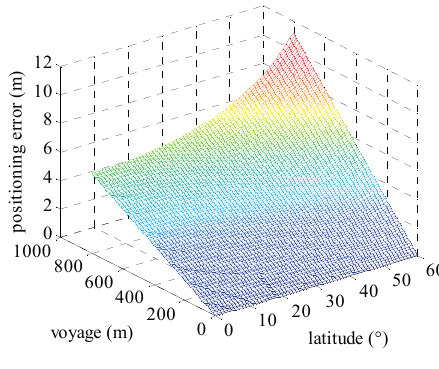
Figure 7. Positioning error influenced by heading